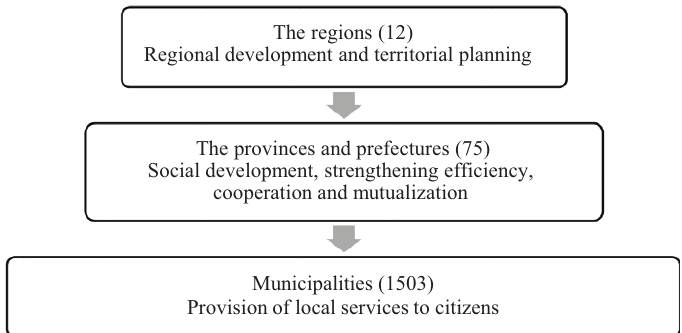
Figure 5. Levels of LA in Morocco (source: author’s